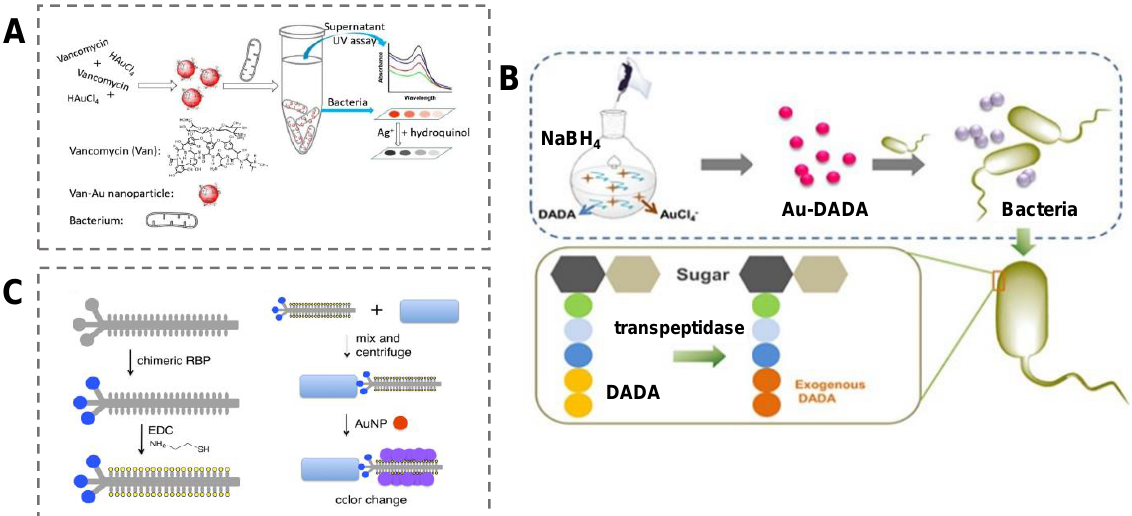
Figure 3. Colorimetric detection of pathogens based on small-molecule-functionalized AuNPs. ( A ) A colorimetric assay using vancomycin-decorated Au nanoparticles for bacteria detection. Reproduced with permission [68]. Copyright 2019, Elsevier. ( B ) A colorimetric assay with D-amino acid- AuNPs for bacteria detection. Reproduced with permission [70]. Copyright 2018, Ivyspring International. ( C ) A colorimetric sensor with antibody-attached AuNPs for rapid SARS-CoV-2 virus detection. Reproduced with permission [72]. Copyright 2019, American Chemical Society.